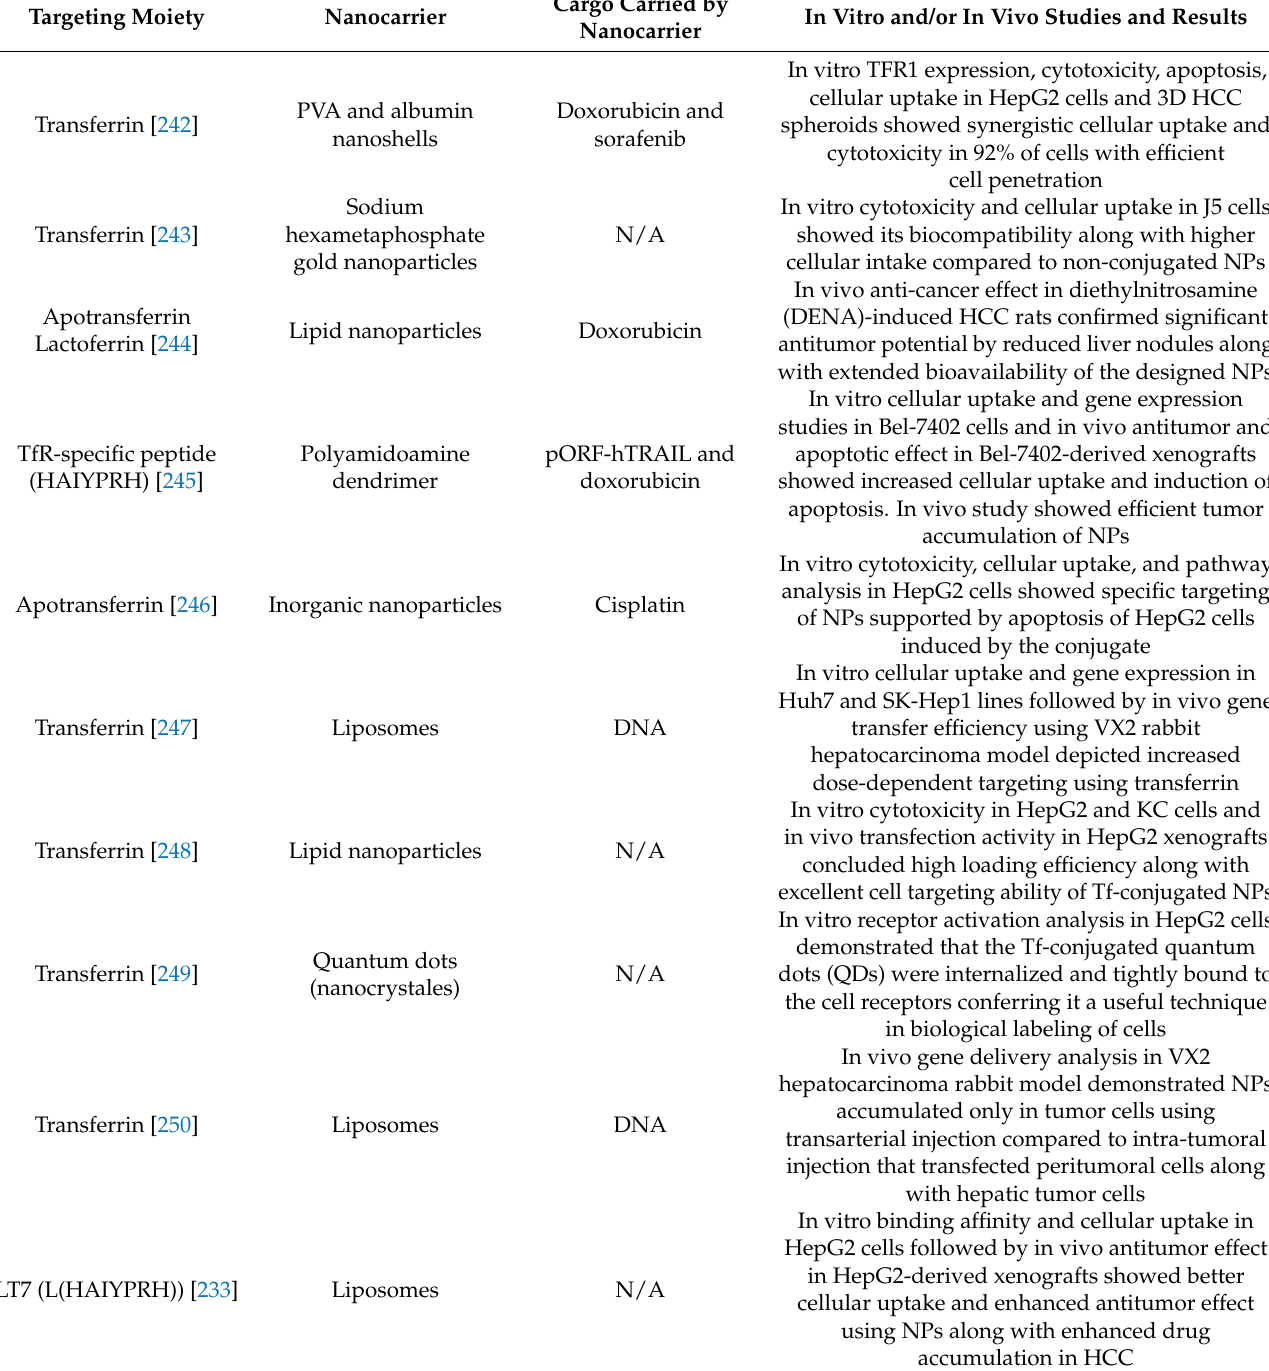
Table 4. Different nanoformulations using transferrin receptors as a potential HCC